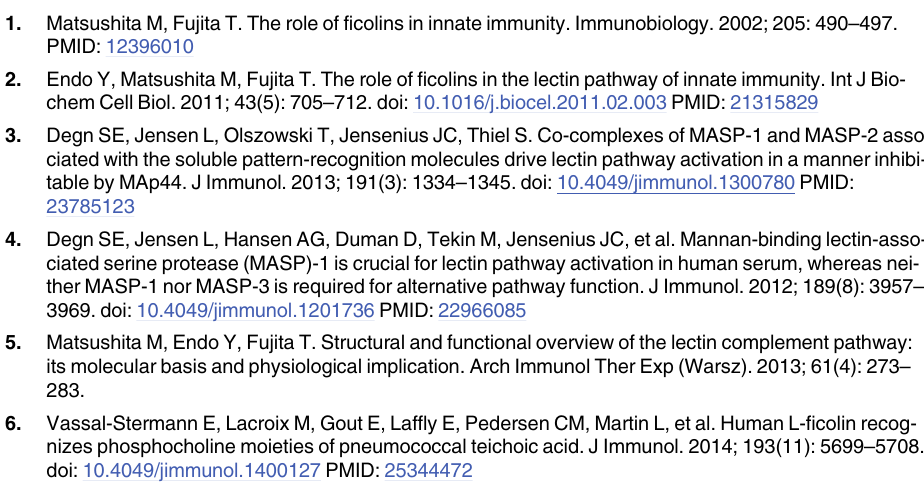
S1 Fig. SPR analysis of human IgG, IgM and recombinant MBL binding to recombinant ficolin-3. Ficolin-3 was immobilized on a CM5 chip and IgG, IgM and MBL were used as ana- lytes. Analytes concentrations are indicated adjacent to sensorgrams. RU, resonance units. (TIFF) S2 Fig. SEC-HPLC chromatography of plasma-derived ficolin-3 complexes on G6000Hr column. Absorbance was monitored at 280 nm. S3 Fig. Detection of immunoglobulins, thrombin, C1q and CL-11 in plasma-derived fico- lin-3 complexes. Microtiter plate was coated by LPS 1200 and 500 ng of plasma-derived fico- lin-3 complexes were added, and followed by ficolin-3, IgA, IgG, IgM, thrombin, C1q and CL- 11 detection (grey bars). In case of control, the addition of plasma-derived ficolin-3 complexes (white bars) was omitted. S4 Fig. Detection of ficolin-3-complexed and free immunoglobulins in plasma-derived ficolin-3 complexes. The presence of immunoglobulins bound to ficolin-3 interacting with LPS 1200 was detected for native (grey bars) and heat-inactivated (56°C) (white bars) ficolin-3